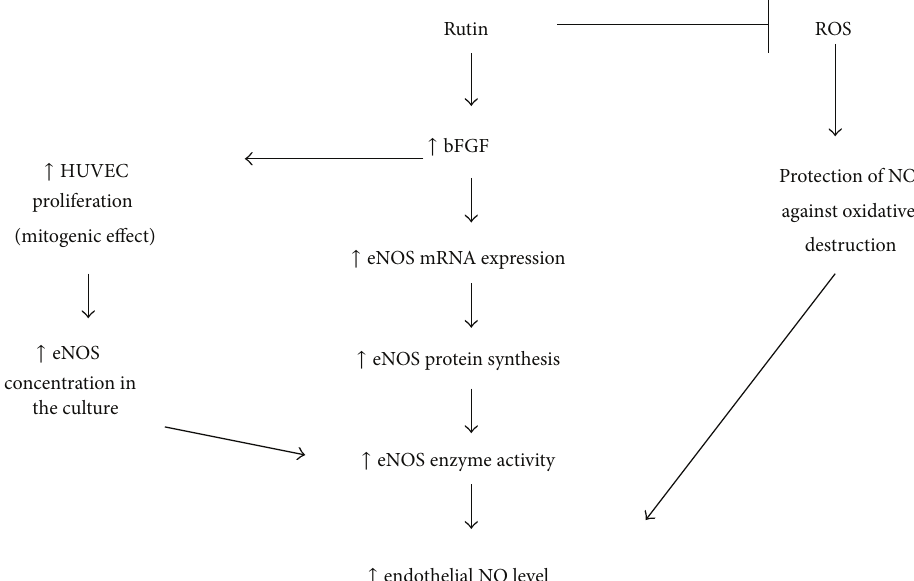
Figure 7: Schematic representation of mechanisms involved in rutin-mediated NO synthesis in